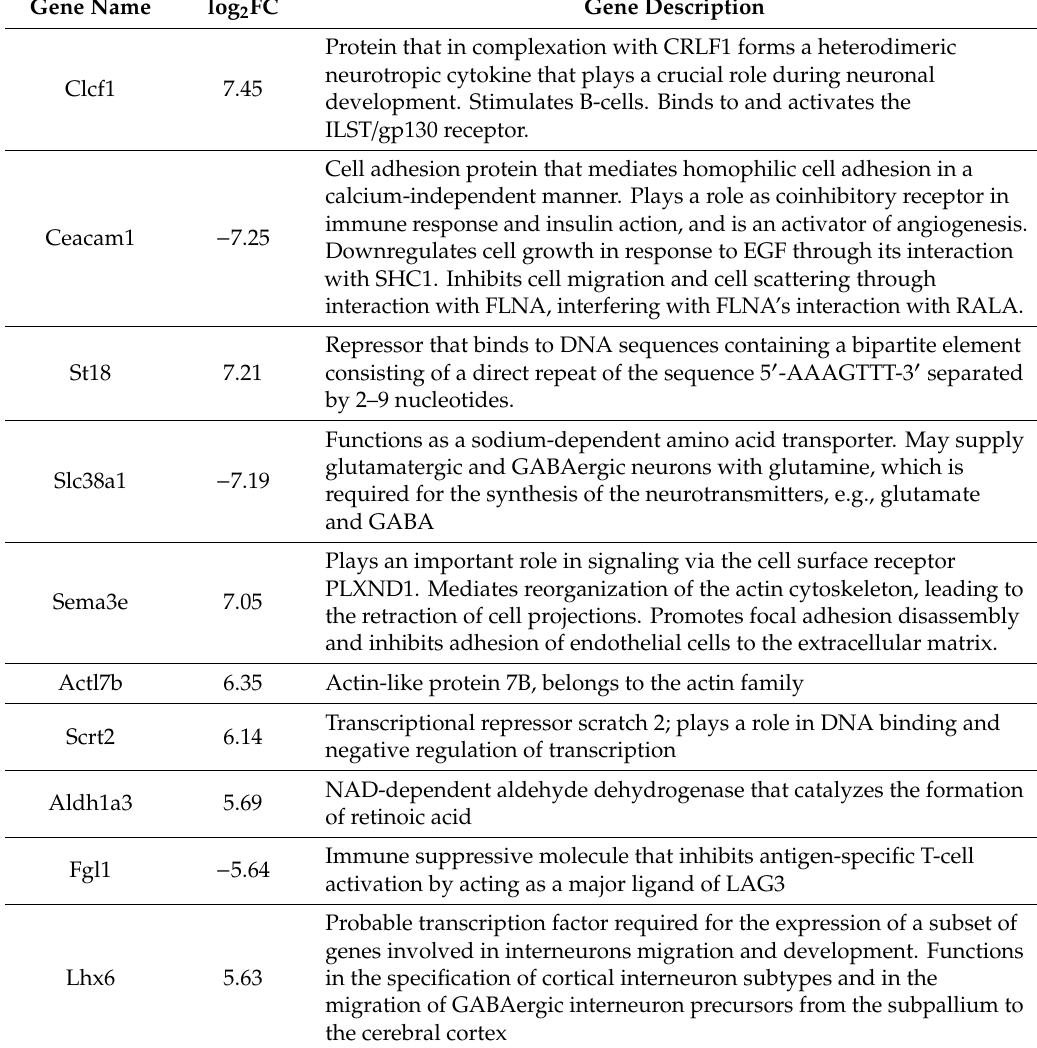
Table 2. Gene description and fold change of top 10 deregulated RNAs after transcriptome